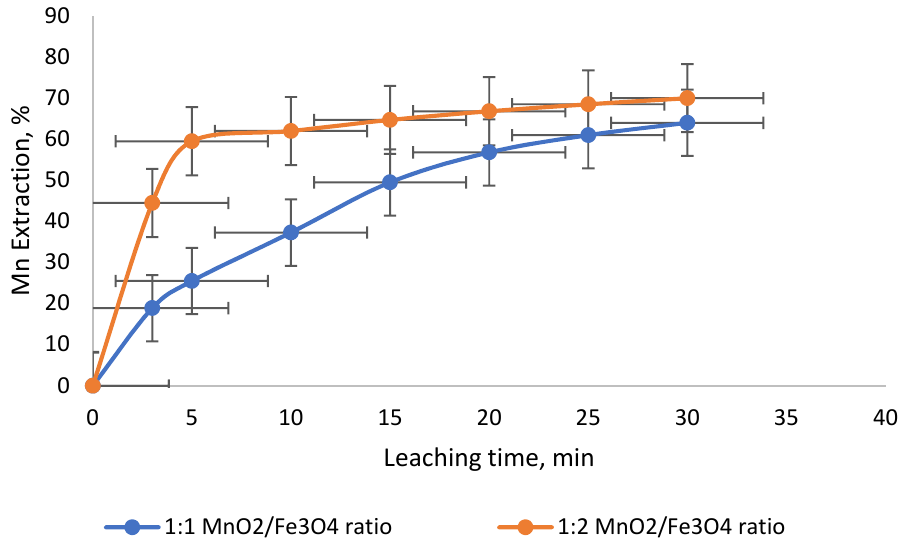
Figure 2. Manganese dissolution from black copper minerals at different ratios of MnO 2 /Fe 3 O 4 and 0.1 mol/L H 2 SO 4 .